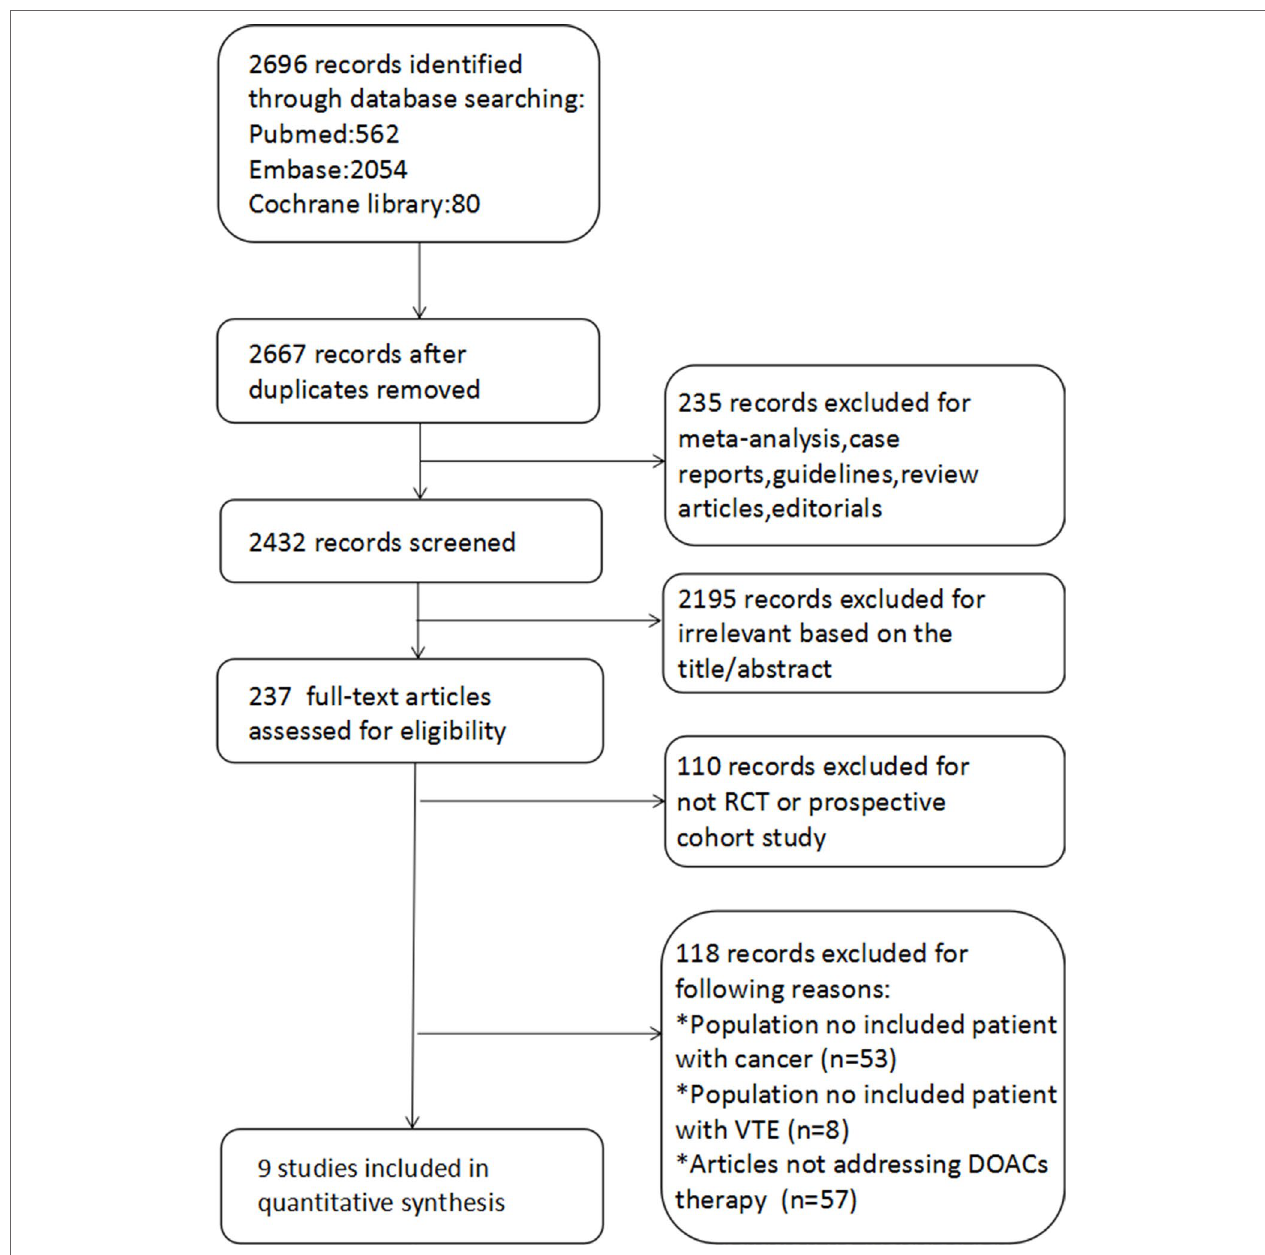
FIGURE 1 | The flow